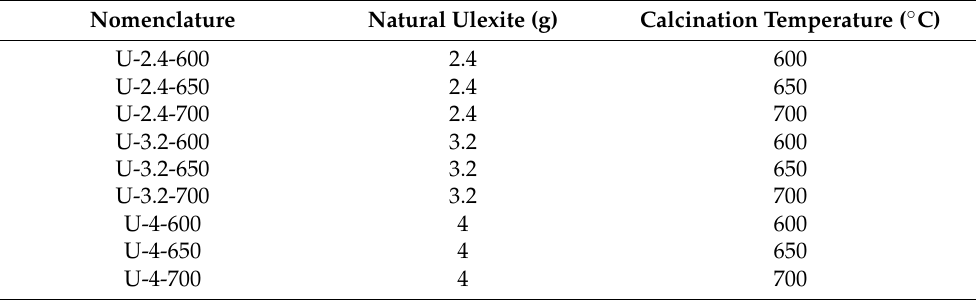
Table 6. Formulation of ceramic papers obtained by varying the amount of binder and calcination